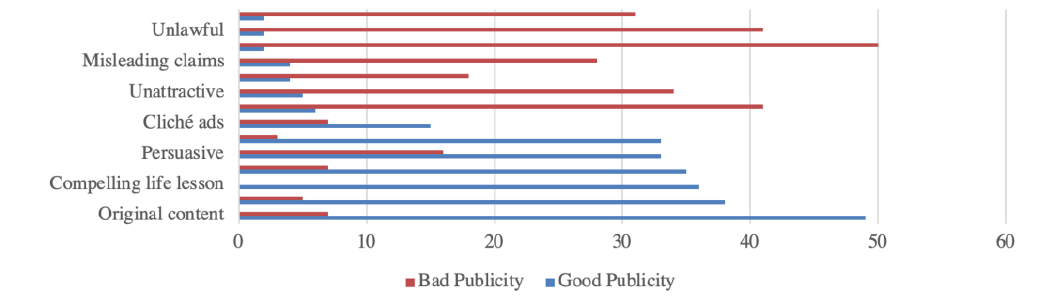
Figure 2: Attributes Associated with Good Publicity and Bad